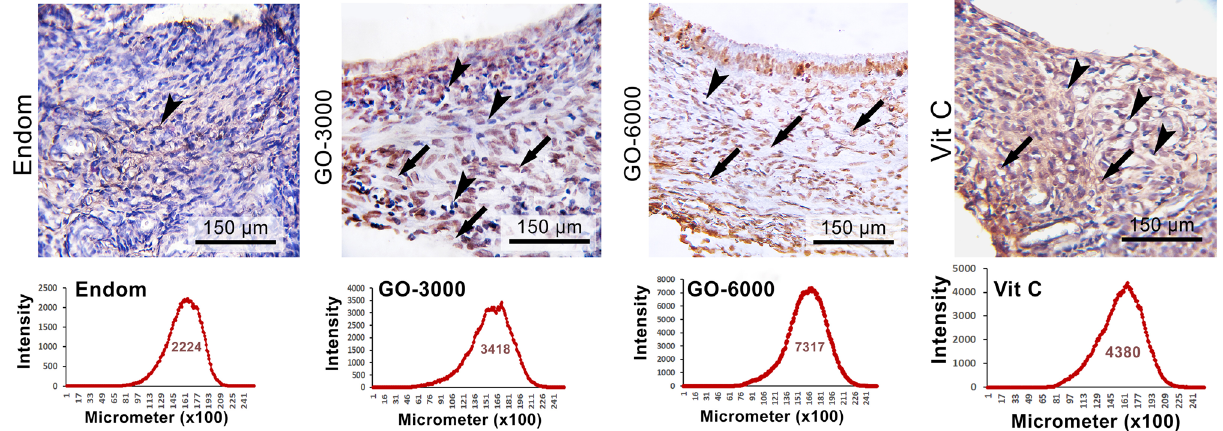
Figure 4. TUNEL staining of ectopic endometrial tissue. Of note, apoptotic cells increased in Vit C-treated GO-6000-treated groups compared to the endom and other experimental groups. As could be seen, the lowest and the highest TUNEL reactions belonged to the section from the endom-group and the section from Vit C and GO-6000,